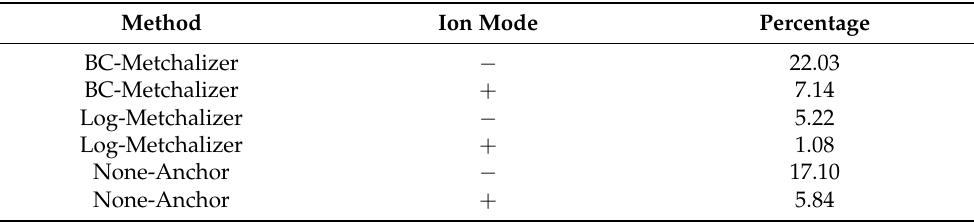
Figure A3. For each normalization method and ion mode the scaled p -value is plotted against the effect size per feature (dot). The effect size is calculated by dividing the coefficient ˆ β Age 1 by the average abundancy of that feature and multiplying the result with 100 %. This effect size measures how the abundancy changes per year (relative to the average abundancy). The red dots indicate features which have a corrected p -value p Age 1 < 0.05 and an absolute effect size > 2 %. ( A ) BC-Metchalizer with negative ion mode data, ( B ) BC-Metchalizer with positive ion mode data, ( C ) Log-Metchalizer with negative ion mode data, ( D ) Log-Metchalizer with positive ion mode data, ( E ) None-Anchor with negative ion mode data, (F) None-Anchor with positive ion mode data. Table A5. Per normalization method and ion mode the percentage of features is displayed having a corrected p -value p Age